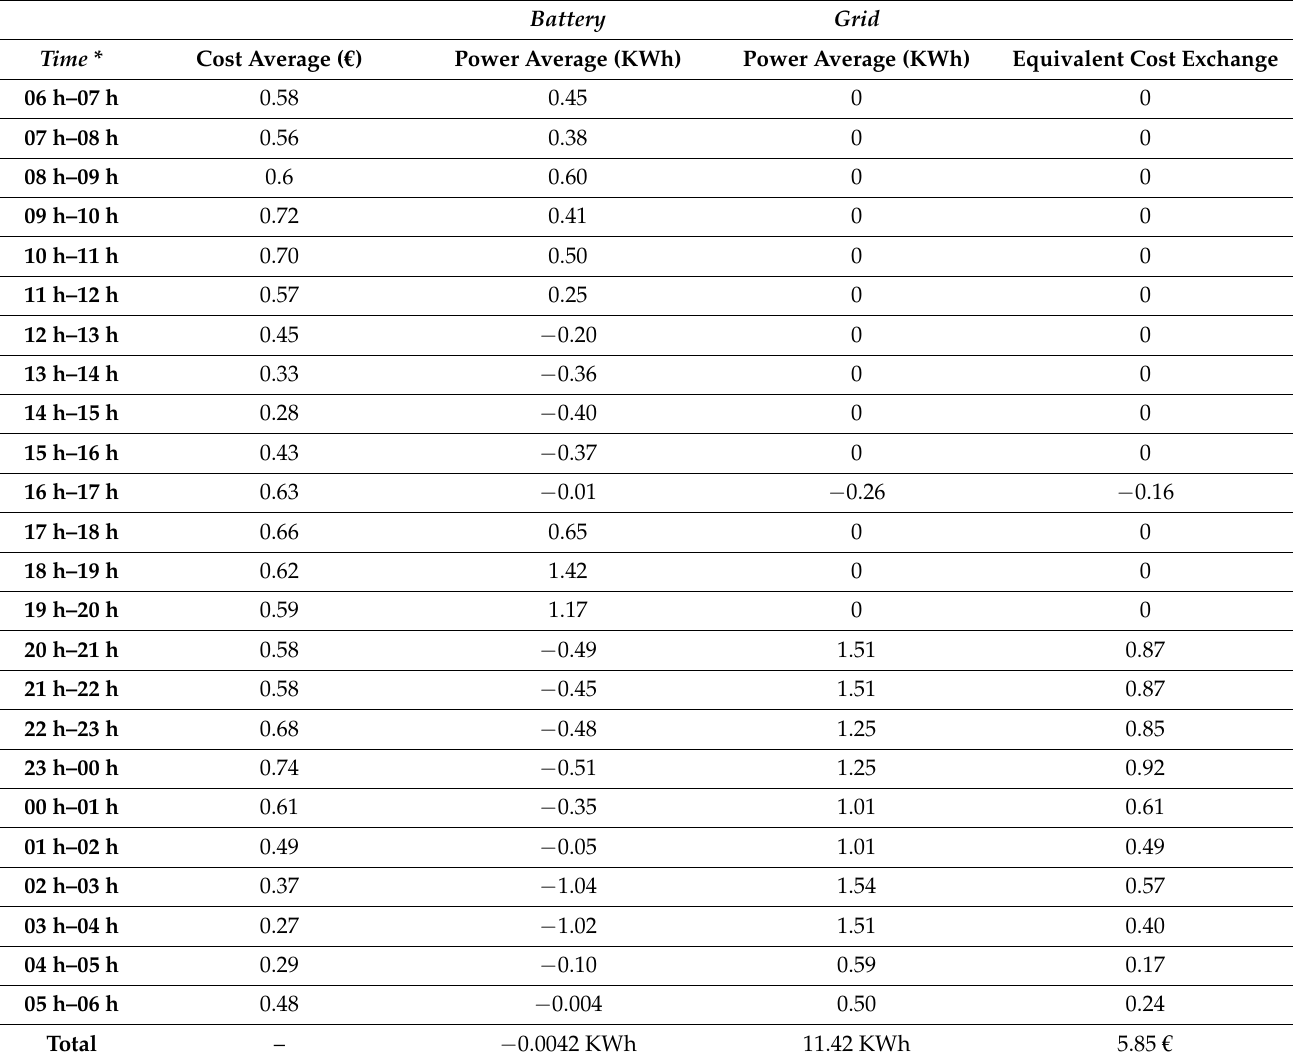
Table 4. Electricity price benefit for Case